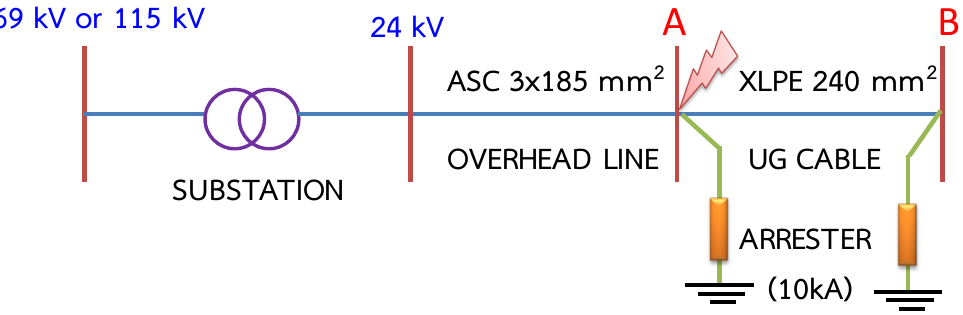
Figure 41. Protection with lightning arrester both at conjunction and the end of underground cables. Table 8. Maximum overvoltage (kV) at point A and B, where the current of the lightning strike to point A is 40 kA.